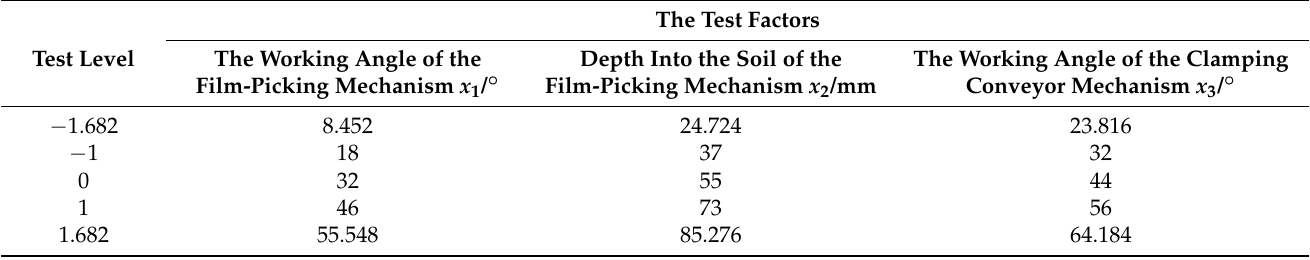
Table 3. Test Factor Level